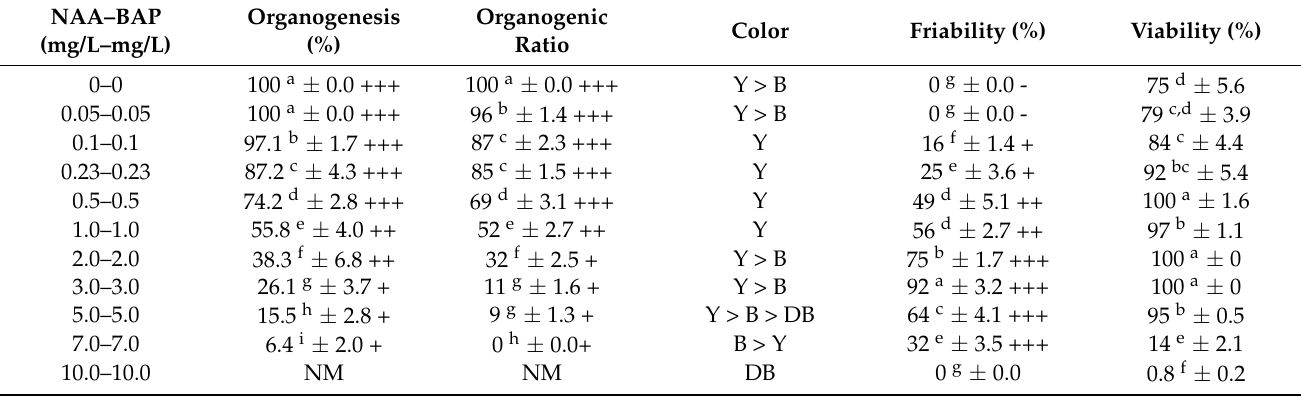
Table 7. Developmental and morphological parameters for callus culture maintained under different PGR combinations (medium MS supplemented with 2.3% sucrose at 18 ◦ C, 0/24 h light/dark, and 8 weeks of